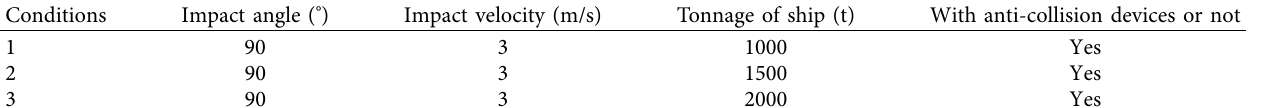
Table 3: Working scenarios of collision of ships of different tonnage.